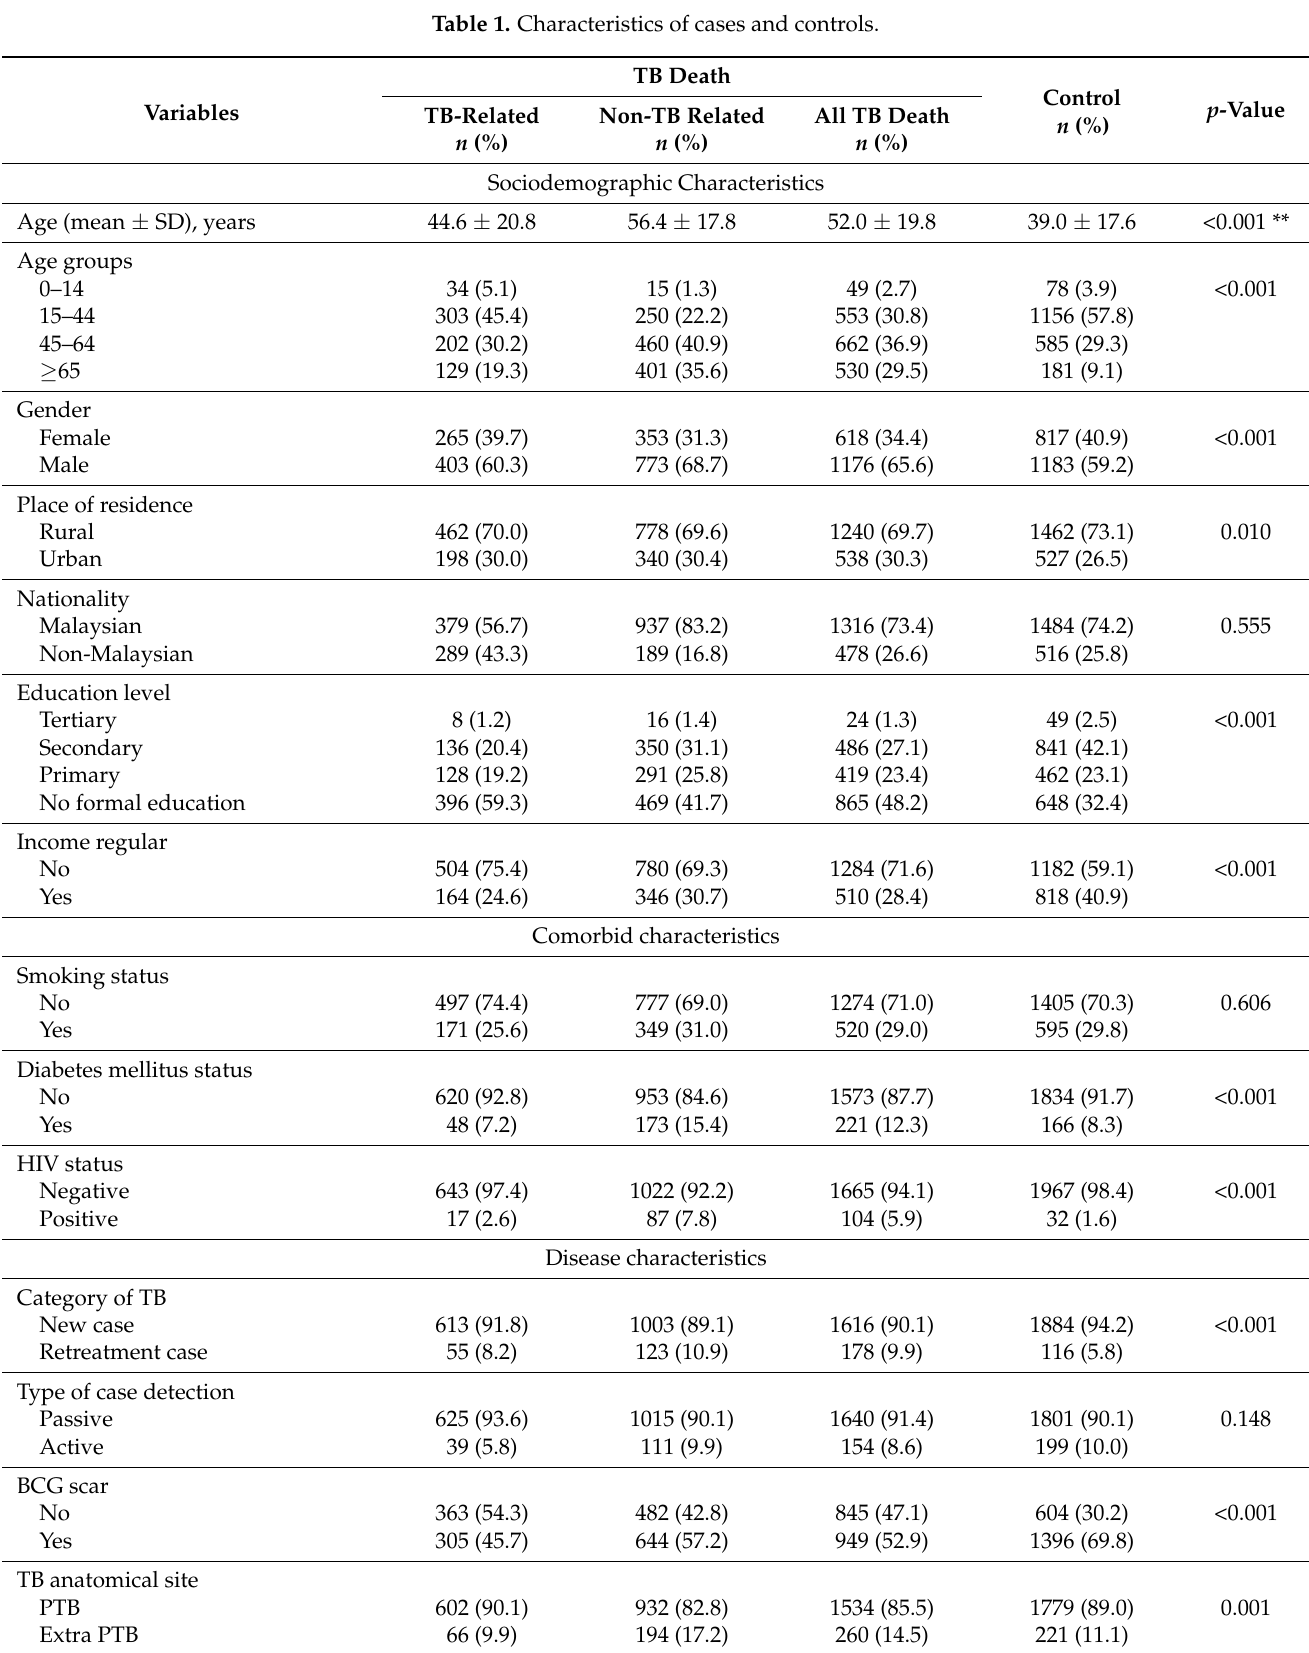
Table 1. Characteristics of cases and